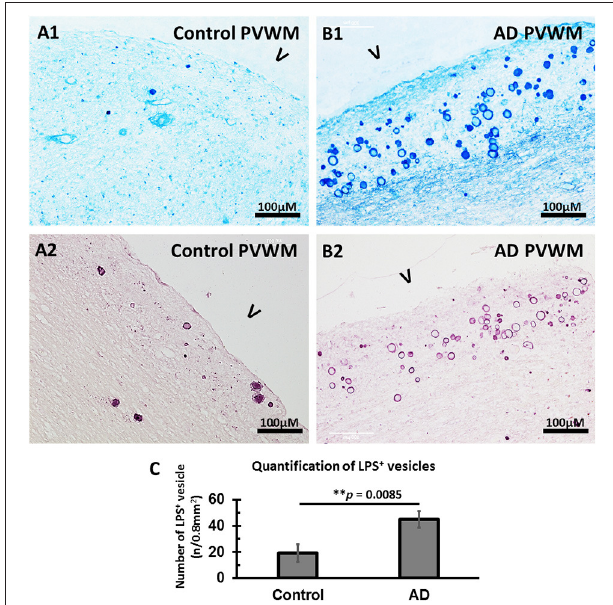
FIGURE 4 | Immunostained LPS vesicles in the PVWM of AD and aging control brains. (A) LPS was identified in the vesicles in control PVWM using an antibody against LPS and staining with alkaline phosphatase and Vector® Blue Substrate Kit (A1) or horseradish peroxidase and Vector VIP Substrate Kit (A2) . (B) LPS was identified in the vesicles in AD PVWM using an antibody against LPS and staining with alkaline phosphatase and Vector Blue Substrate Kit (B1) or horseradish peroxidase and Vector VIP Substrate Kit (B2) . (C) Quantitative analysis showed more LPS + vesicles in AD (44.8 ± 6.5, n = 12) PVWM compared to control PVWM (20.1 ± 6.7, n = 9, p = 0.0085). Note: LPS, lipopolysaccharide; V, ventricle; PVWM, periventricular white matter; AD, Alzheimer’s disease; Bar = 100 µ